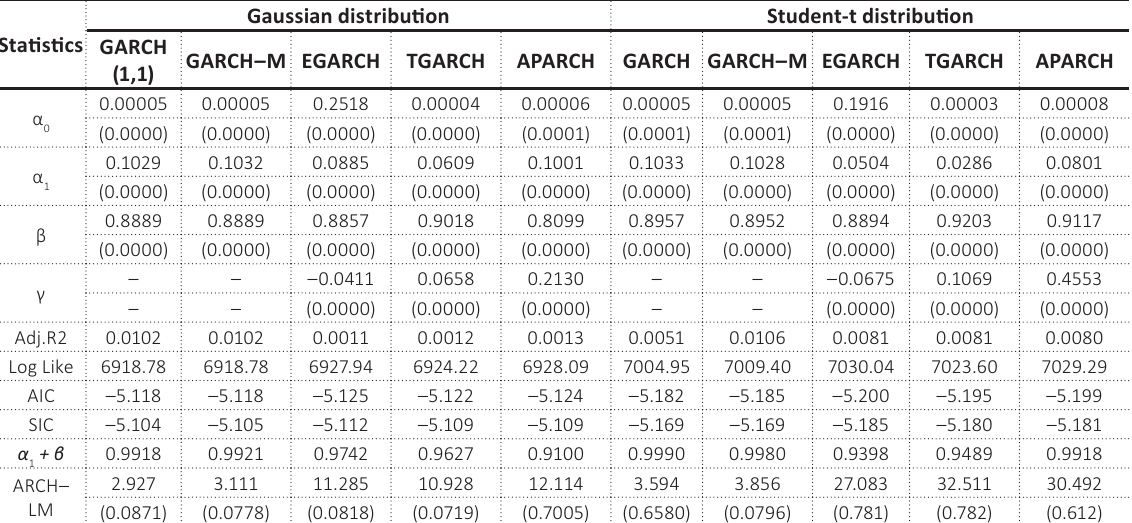
Table 7. Estimation result of GARCH models: Crude